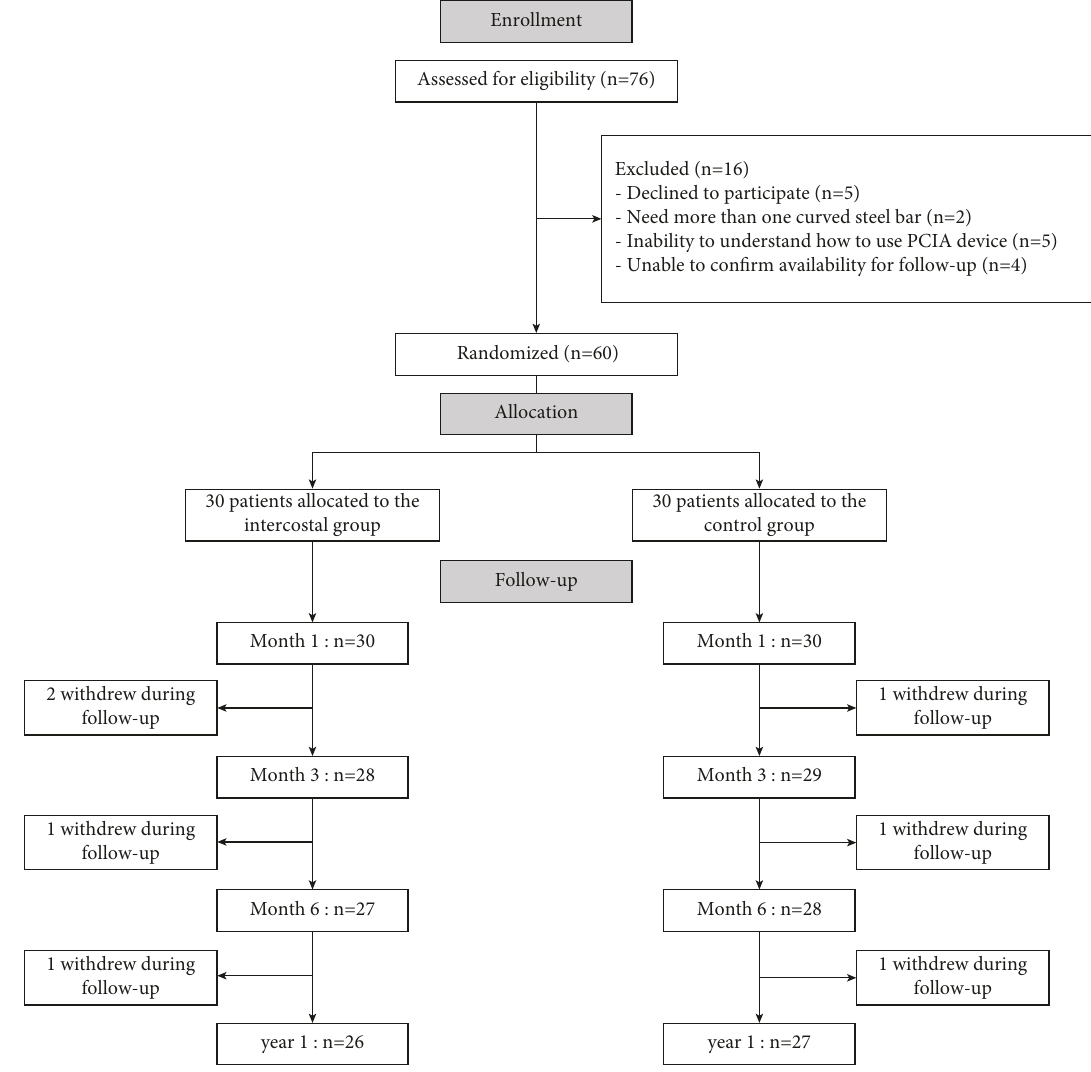
Figure 1: Participant flow diagram for the study. PCIA, patient-controlled intravenous Table 1: Total volume of local anesthetic.